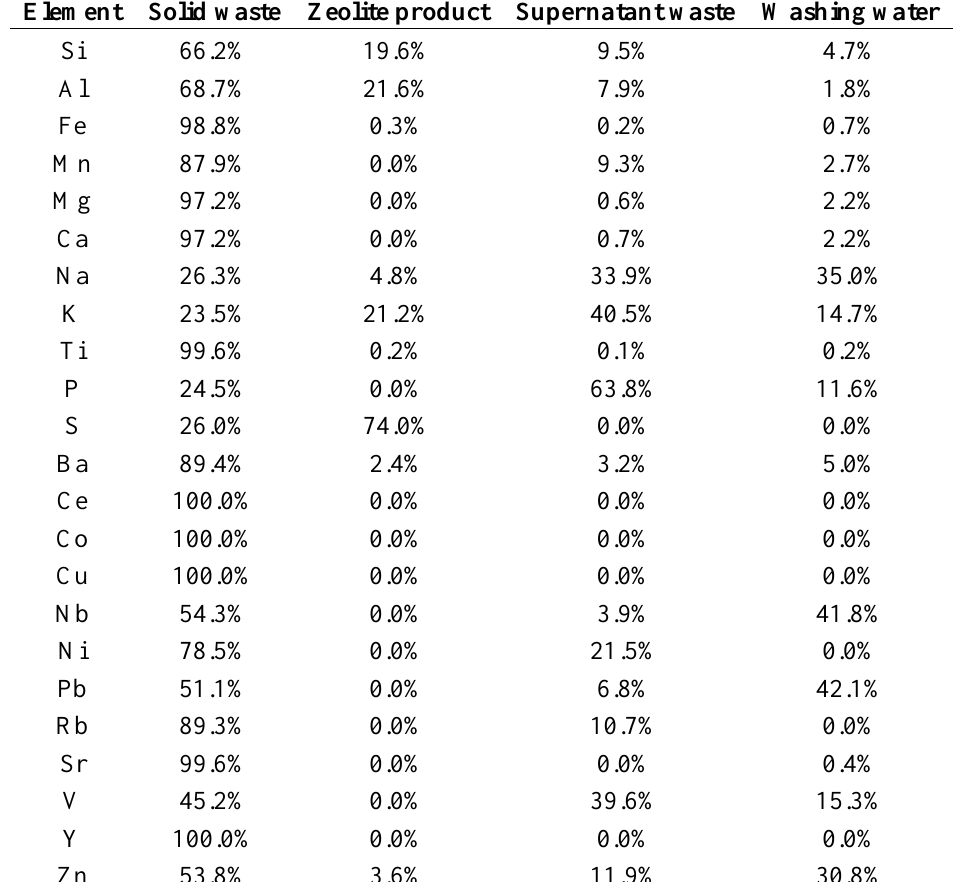
Table 3. Elemental balance illustrating the distribution of the elements (wt%) originating from fly ash amongst the different products resulting from the fusion assisted synthesis